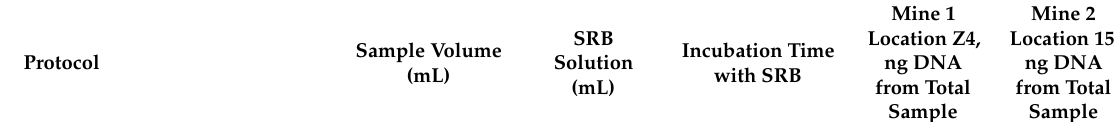
Table A6. Extraction of microbial DNA from samples from Mine 1 (location 24) and Mine 2 (location 15) using commercial DNA extraction kits. In order to test the e ffi ciency of extracting DNA from the solid particles of the samples, the samples were spiked with a culture solution of Desulfovibrio desulfuricans E-95573T cells, a sulfate reducing bacterium (SRB). The amount of DNA in the SRB solution was tested by extracting the DNA from 10 mL of culture by first collecting the SRB cells by centrifugation for 10 min, 3184 × g , on an Eppendorf 5810R benchtop centrifuge, and extracting the DNA from the cell pellet using the Macherey-Nagel Soil DNA extraction kit with lysis bu ff er 1 and SX solution, as recommended by the manufacturer. The DNA extraction was done in duplicate. The amount of DNA was measured using the Qbit fluorometer (Thermo Fisher Scientific). The amount of DNA obtained from 10 mL of SRB culture solution was approximately 180 ng mL − 1 culture. The limit of detection of DNA with the Qubit fluorometer was 0.025 ng / 5 mL sample (i.e., bd = below